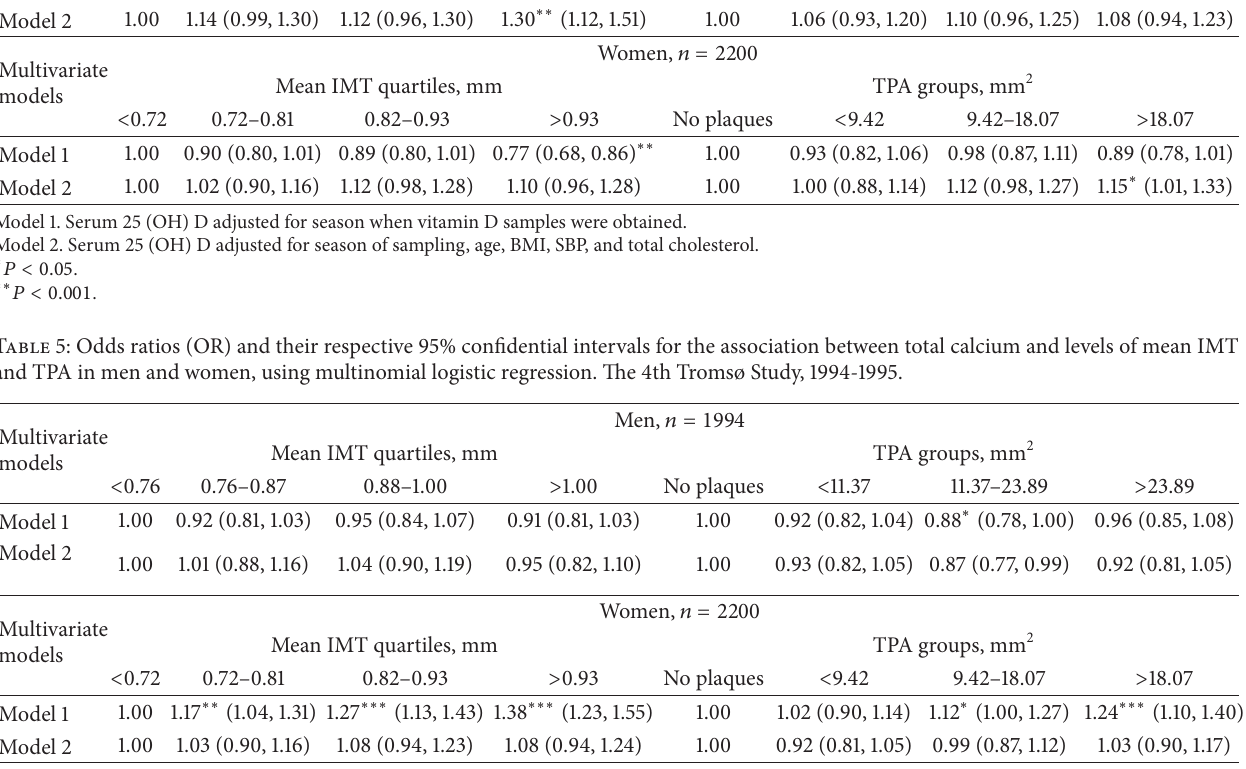
Table 4: Odds ratios (OR) and their respective 95% confidential intervals for the association between serum 25(OH)D and levels of mean IMT and TPA in men and women, using multinomial logistic regression. The 4th Tromsø Study, 1994-1995. Multivariate models